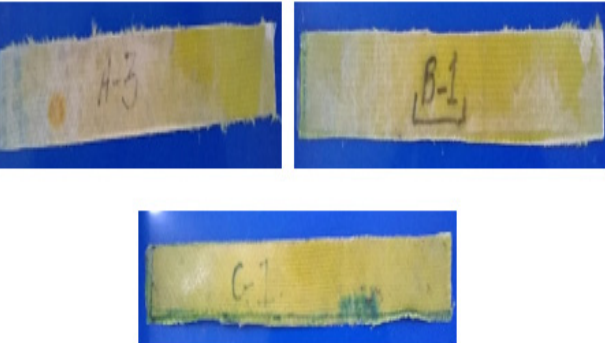
Figure 1. Specimens fabricated using different resin ratios (A = 3:2, B = 4:1, C = 2:3) respectively. Table 1. Layup placement of glass fibers and Kevlar 49 by applying different ratios of resin and hardener. Table 2. Materials properties of E-glass, Kevlar, and epoxy. Layer Layers Formation